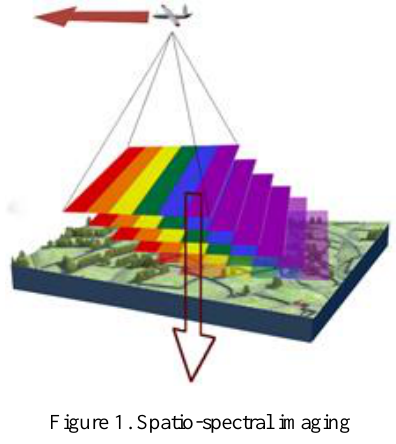
Figure 1. Spatio-spectral imaging